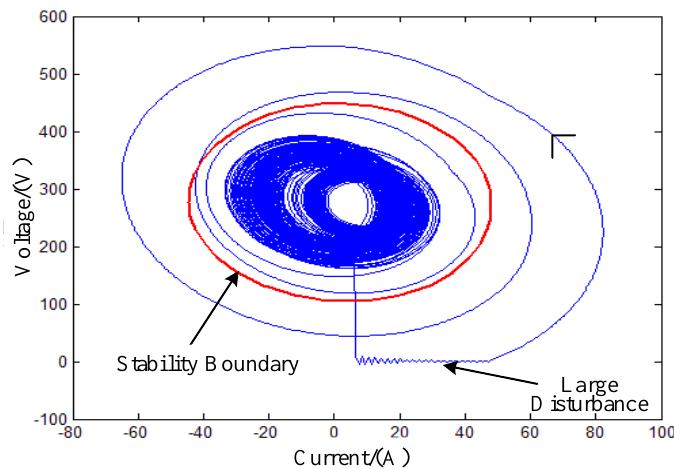
Figure 11. Large disturbance stability domain based on PMSM.